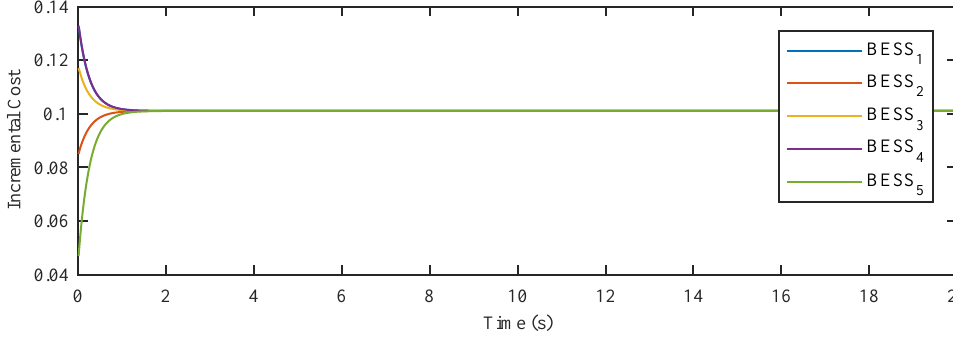
Figure 12. Convergence curve of incremental